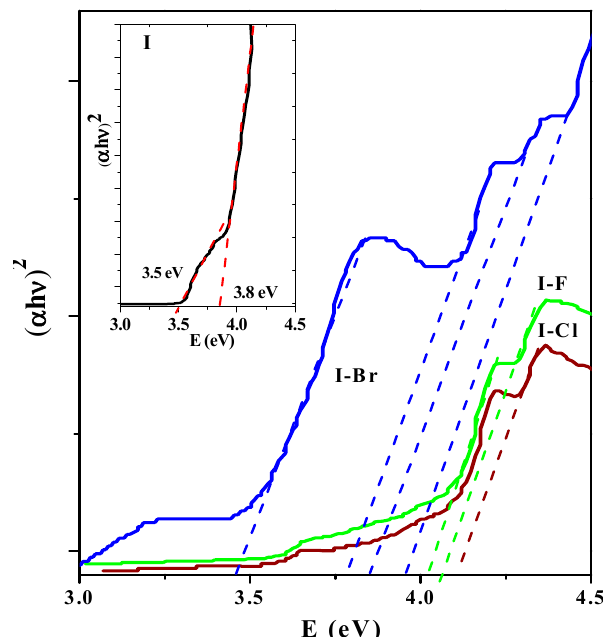
Figure 8. ( α h ν ) 2 vs. (h ν ) plot of I − X crystals. Inset shows ( α h ν ) 2 vs. (h ν ) of I spectra. In I − F and I − Cl samples, the so-called Urbach tail generated by crystal defects located in the ~3.7–4.3 photon energy range can be seen. Table 5. Experimental electronic transitions (E g ) of I , I − F , I − Cl , and I − Br crystals.